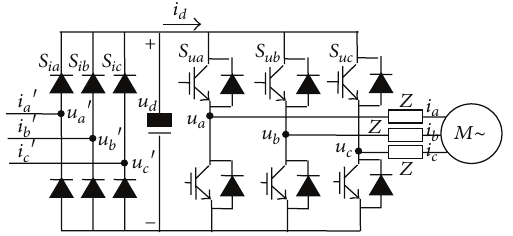
Figure 1: Schematic diagram of the PWM VSI-fed adjustable speed